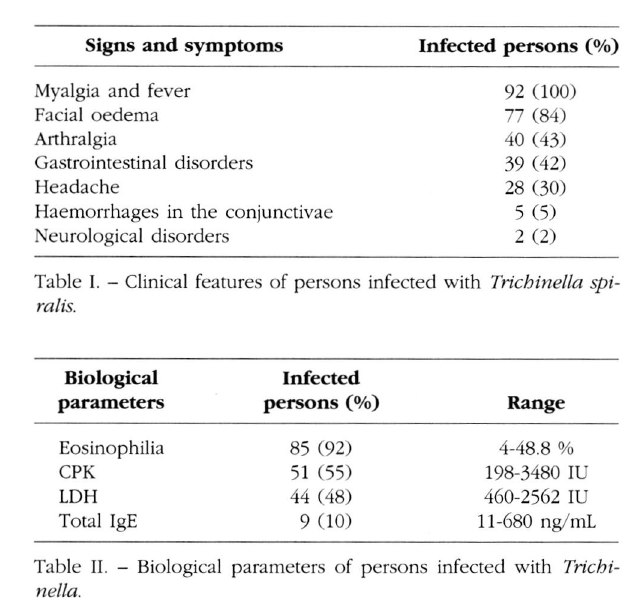
Table II. - Biological parameters of persons infected with Trichi